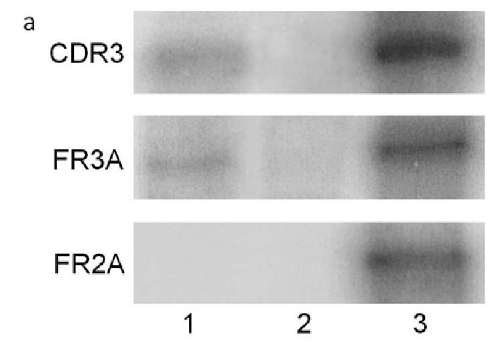
Figure 2. PCR of gene rearrangements in two patients with PVRL: ( a ) IgH gene rearrangement of B-cell PVRL was detected using primer pairs of CDR3 and FR3A but not FR2A. ( b ) TCR gene rearrangement of T-cell PVRL was detected using primer pairs of TCR-gamma and TCR-CDR (Lane 1, vitreous specimen; Lane 2, negative control; Lane 3, positive